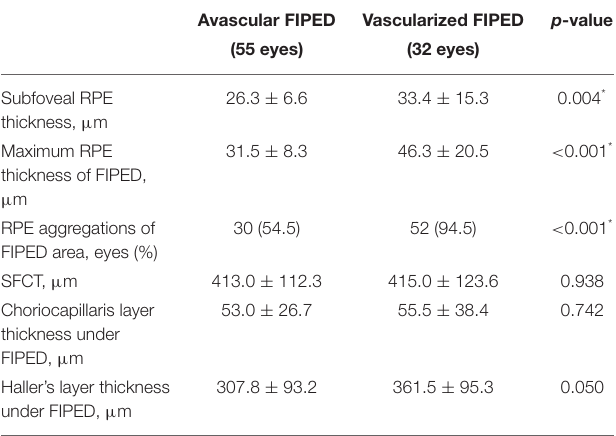
TABLE 3 | RPE and choroid status features of avascular and vascularized FIPEDs in chronic CSC. Avascular